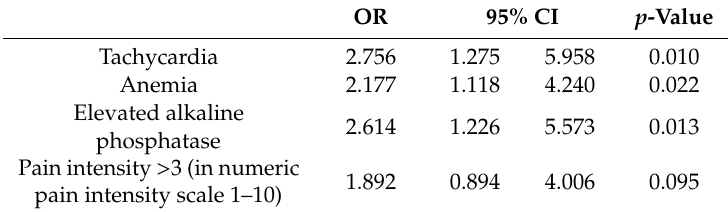
Table 4. Multivariate analysis of parameters associated with re-visiting ED in 30